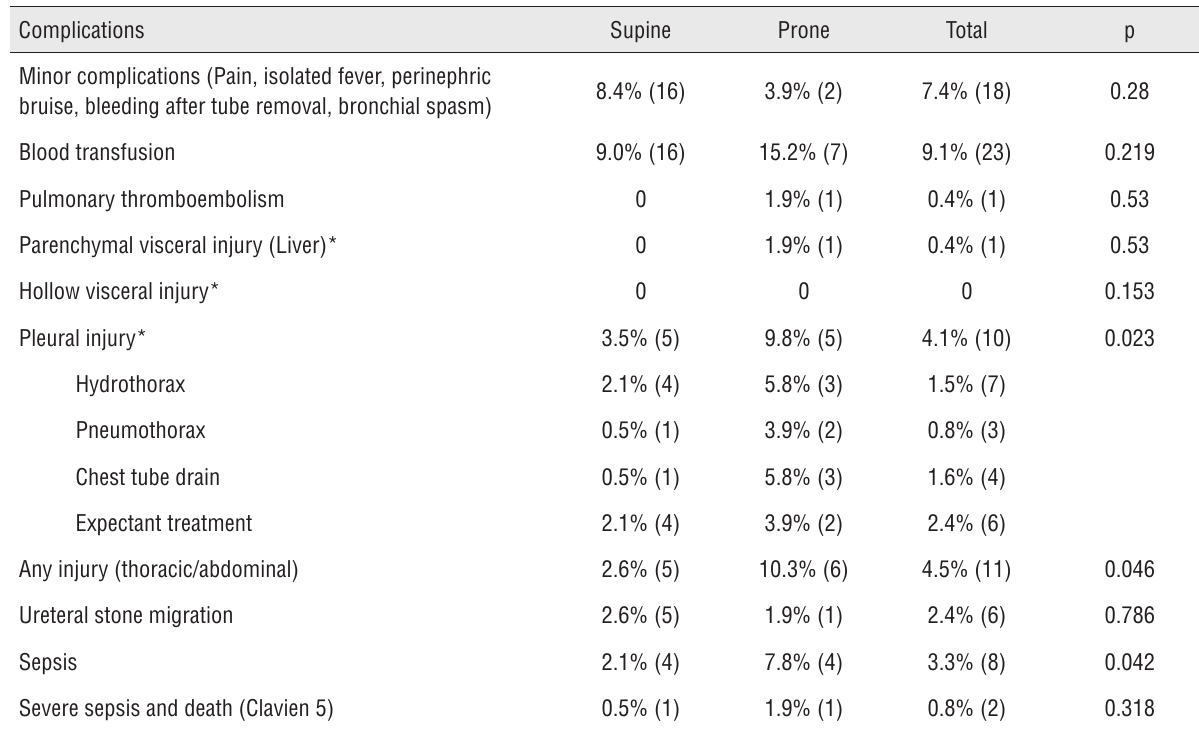
Ureteral stone migration Sepsis Severe sepsis and death (Clavien